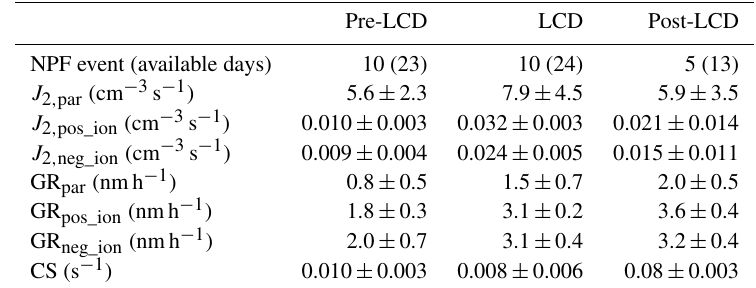
Table 1. Parameters characterizing NPF events during pre-LCD, LCD, and post-LCD, including NPF frequency, formation rate ( J 2 , par , J 2 , pos_ion , J 2 , neg_ion ), and growth rate (GR 2 , par , GR pos_ion , GR neg_ion ) of the total particles and charge ions, as well as condensation sink (CS).